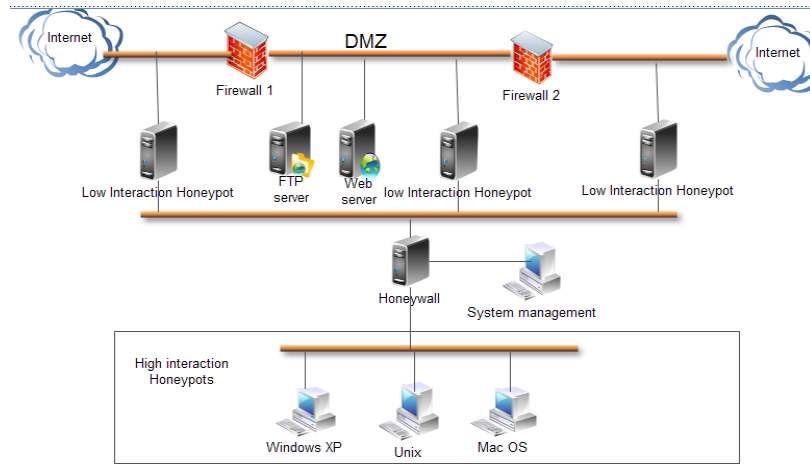
Fig. 6. Proposed System Implementation on the three